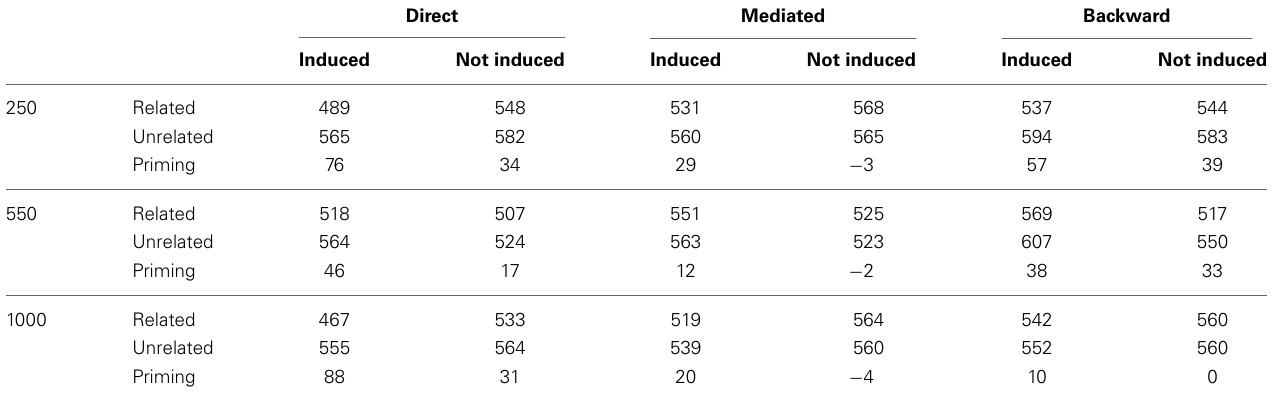
Table 1 | Mean reaction times across subjects (ms) in Experiment 1 7